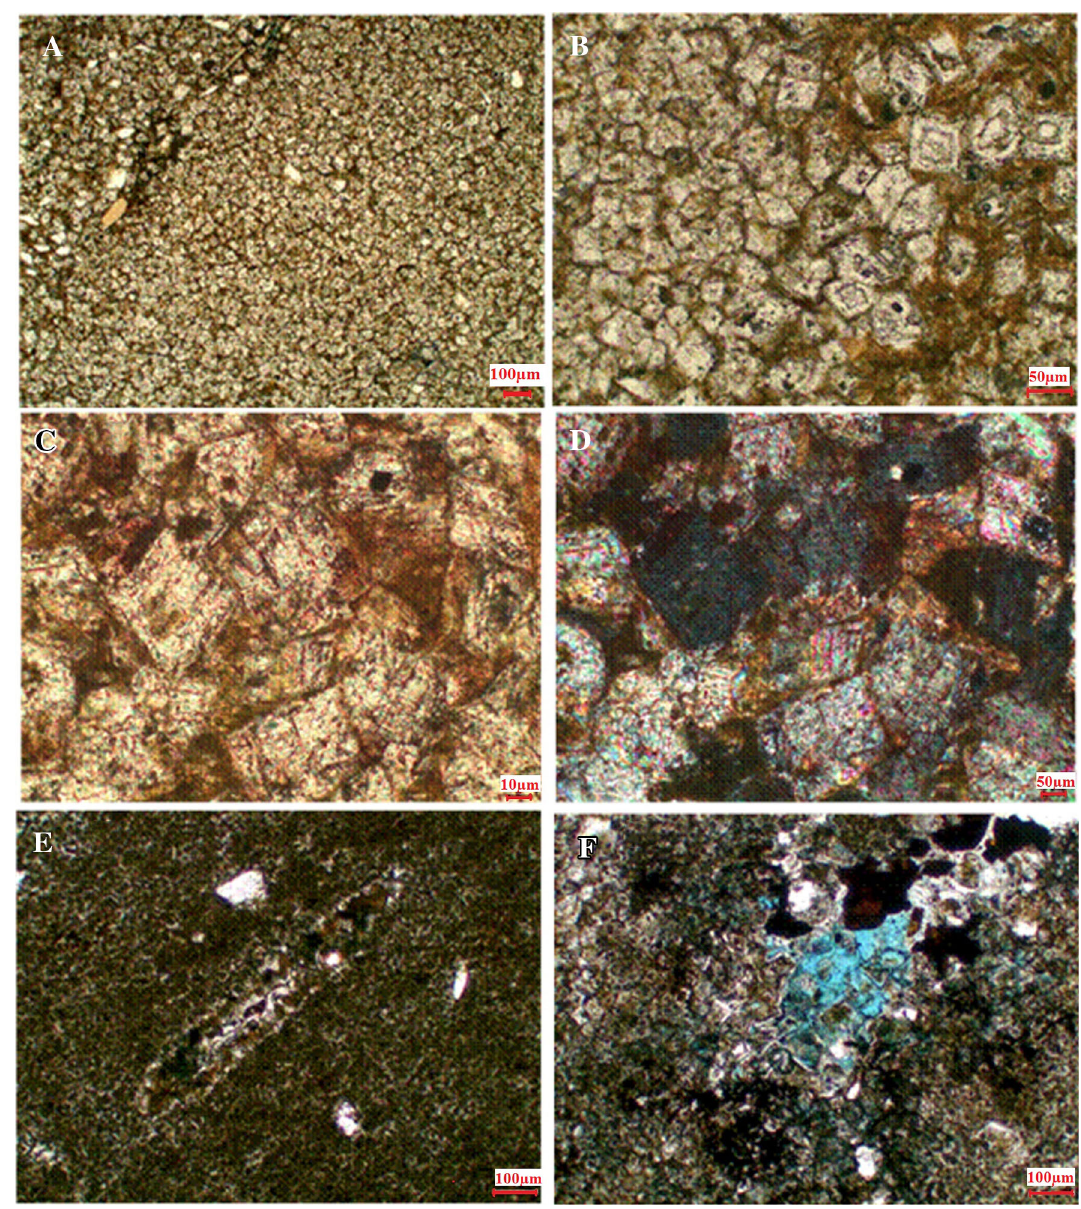
Fig. 7 a , b photomicrograph showing very fine crystalline planar-e mosaic-zoned dolomite. c , d showing very fine crystalline planar-e to planar-s zoned dolomite PPl &CN. e showing very fine crystalline